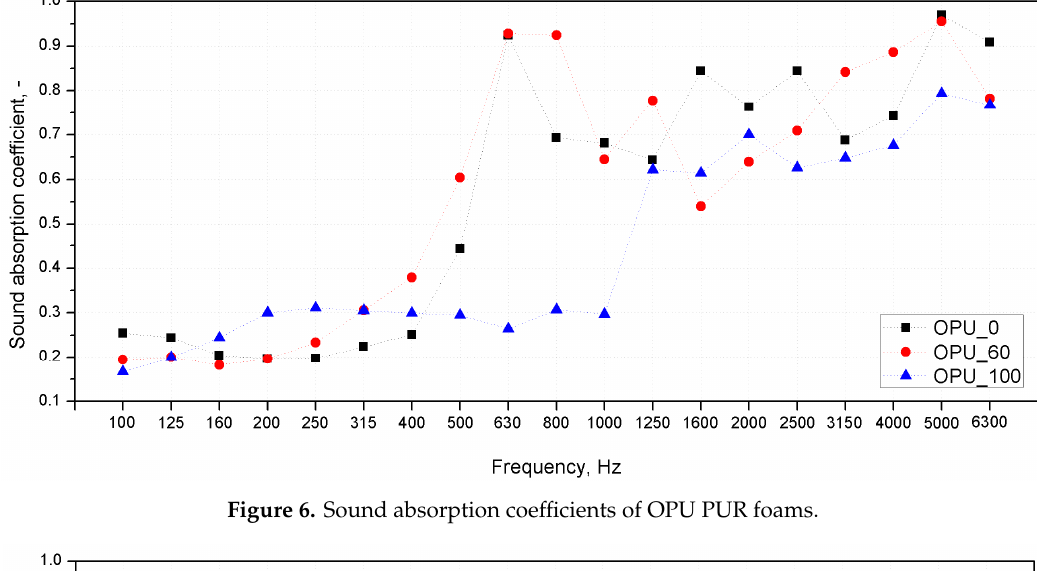
Figure 6. Sound absorption coefficients of OPU PUR foams.